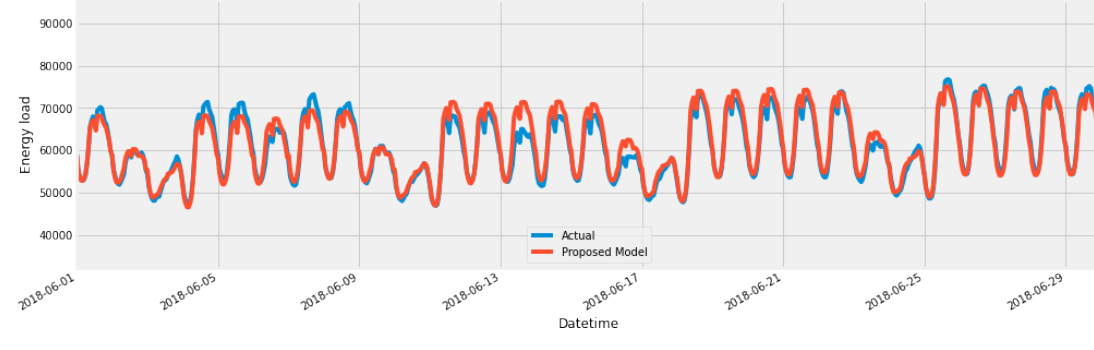
Figure 17. Forecast for the month of June.